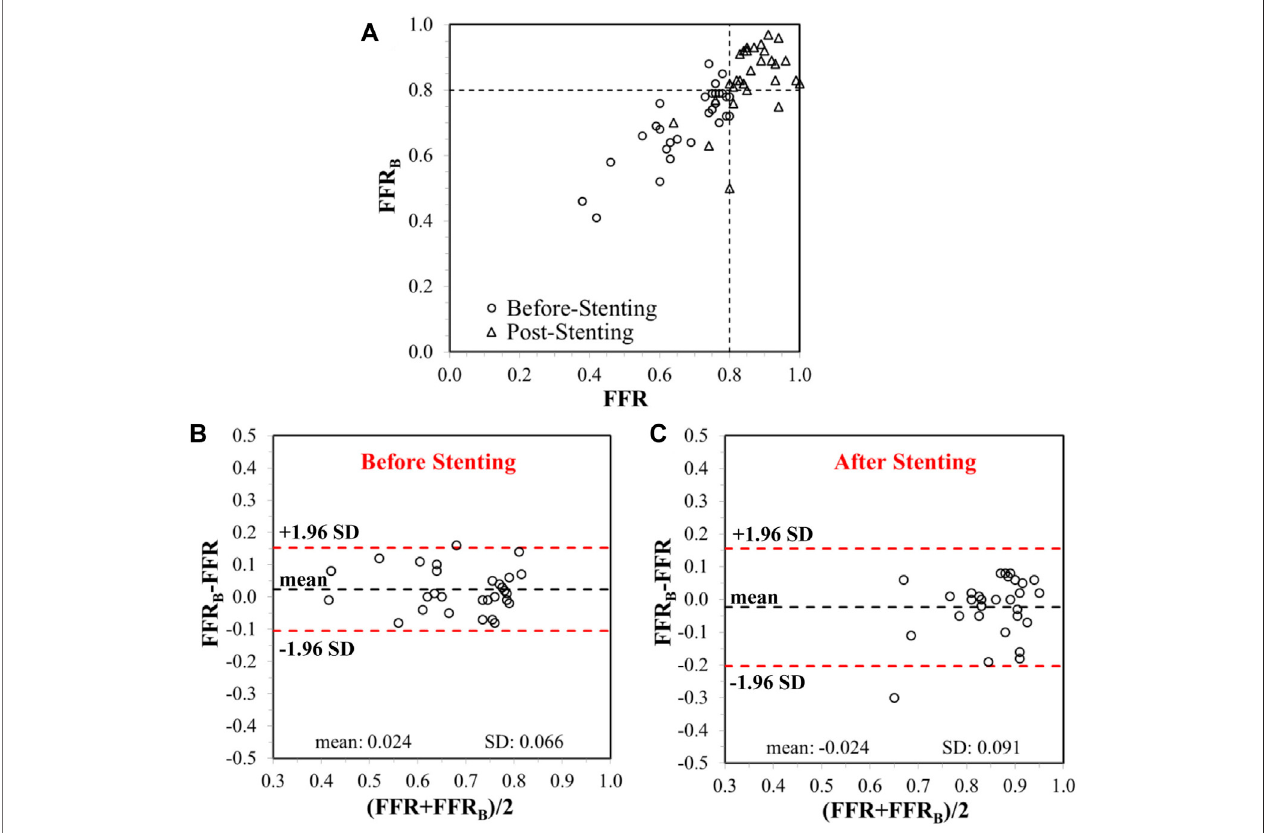
FIGURE4|(A) CorrelationbetweeninvasiveFFRandFFR B ,beforeandafterstenting.TheverticalandhorizontaldashedlinesrepresentthethresholdsforFFRand FFR B , respectively, for ischemic classi fi cation of lesions. Bland-Altman plots showing limits of agreement on differences between FFR and FFR B (B) before and (C) after